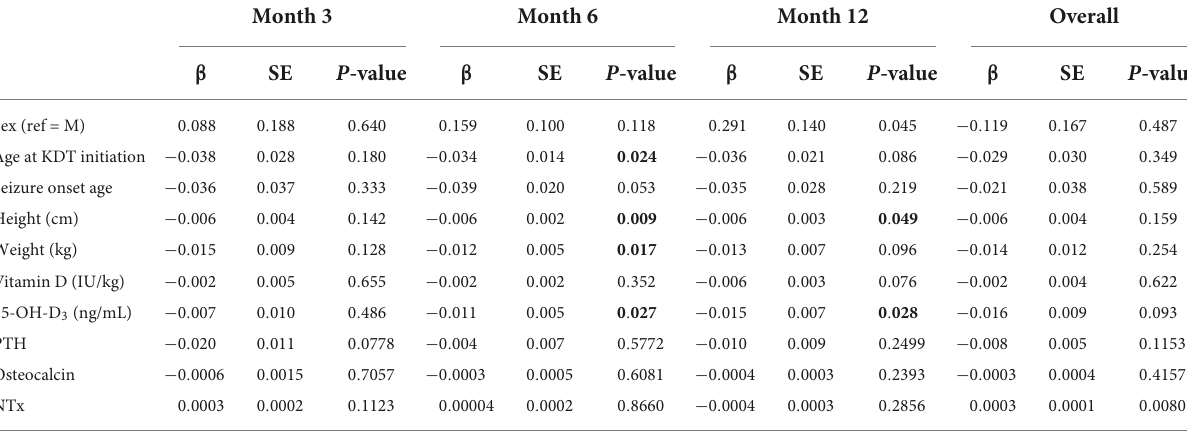
TABLE 2 Factors affecting the ratio of urinary excretion of calcium (Uca) to urinary excretion of creatinine ratio (Ucr) using longitudinal mixed-effect